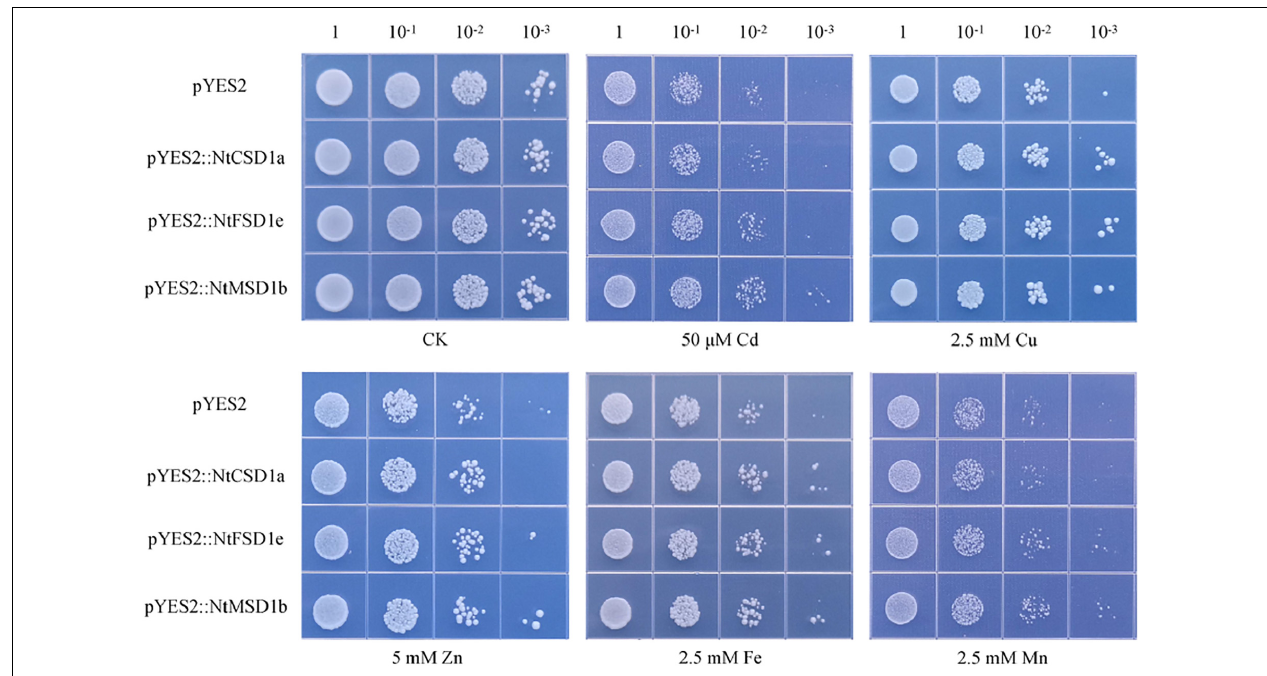
FIGURE 8 | Effect of NtSOD gene expression in oxidation-sensitive yeast (cid:49) yap1 on yeast cell growth in response to different heavy metal stresses (50 µ M Cd, 2.5 mM Cu, 5 mM Zn, 2.5 mM Fe, and 2.5 mM Mn). The numbers above the data represent the dilution times of the bacterial solution.